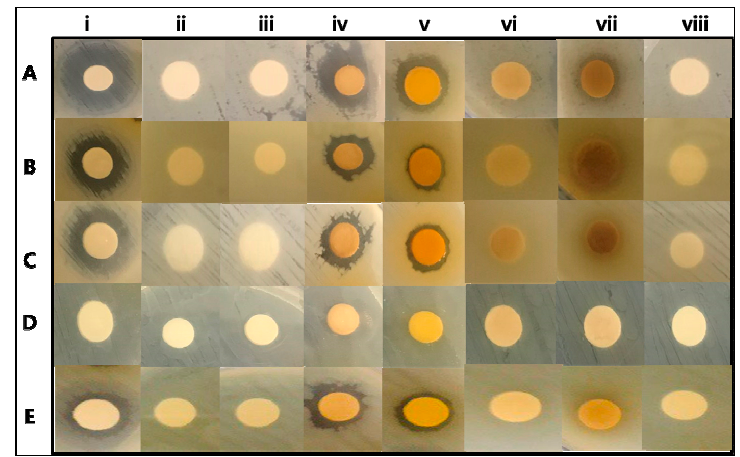
Figure 6. In vitro antibacterial activity of T. vernicifluum . Staphylococcus aureus ( A ), Salmonila enteria subp.enterica ( B ), Pseudomonas aeruginosa ( C ), E. coli ( D ), and Bacillus cereus ( E ); Antibiotics oxacillin (i),